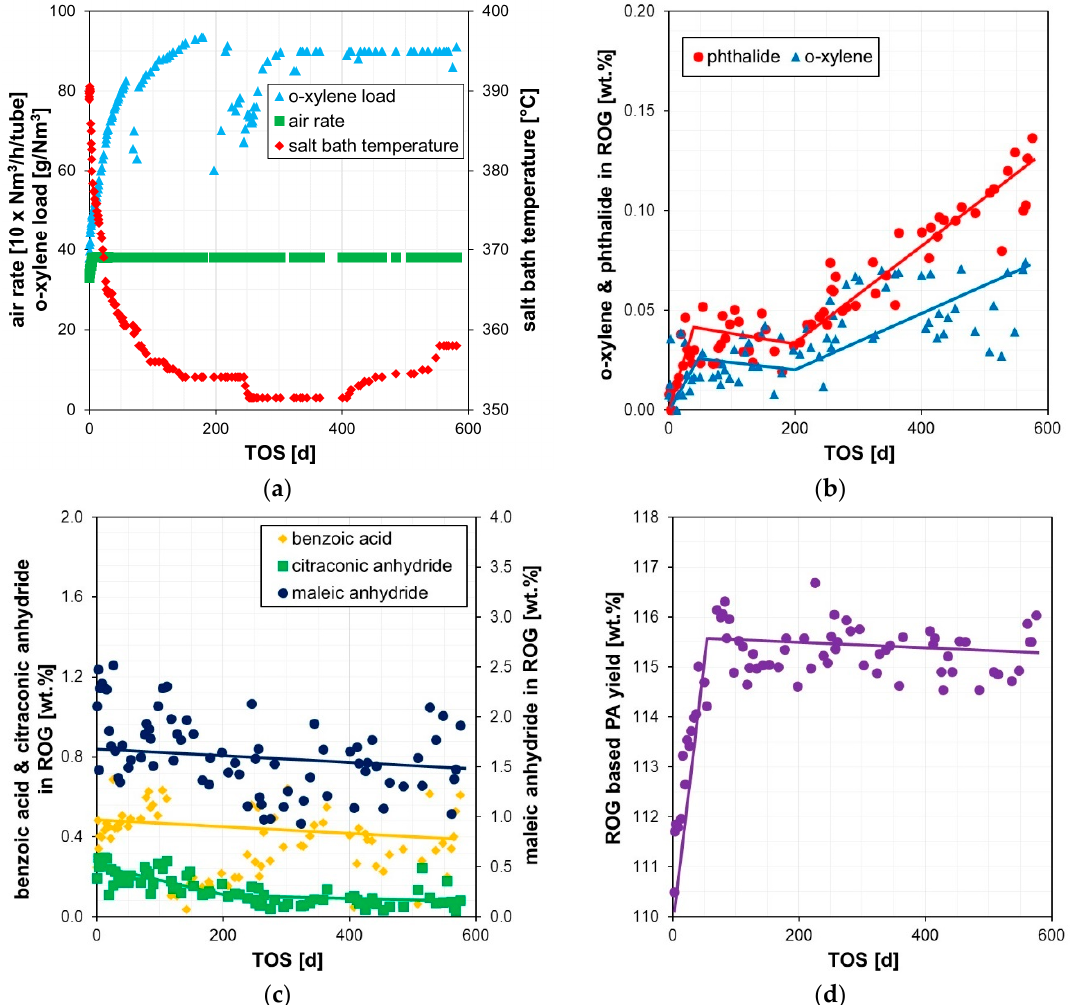
Figure 3. Evolution vs. time-on-stream (TOS) of: ( a ) process parameters (o-xylene (oX) load, air rate, salt bath temperature); ( b ) under-oxidation by-products in the reactor off-gas (phthalide, o-xylene); ( c ) over-oxidation by-products in the reactor off-gas (maleic anhydride, benzoic acid, citraconic anhydride); ( d ) reactor off-gas based PA yield.